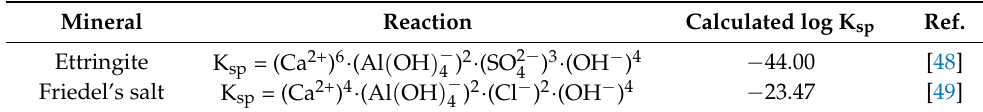
Table 6. Thermodynamic equilibrium constant of ettringite and Friedel’s salt at 25 ◦ C. Mineral Reaction